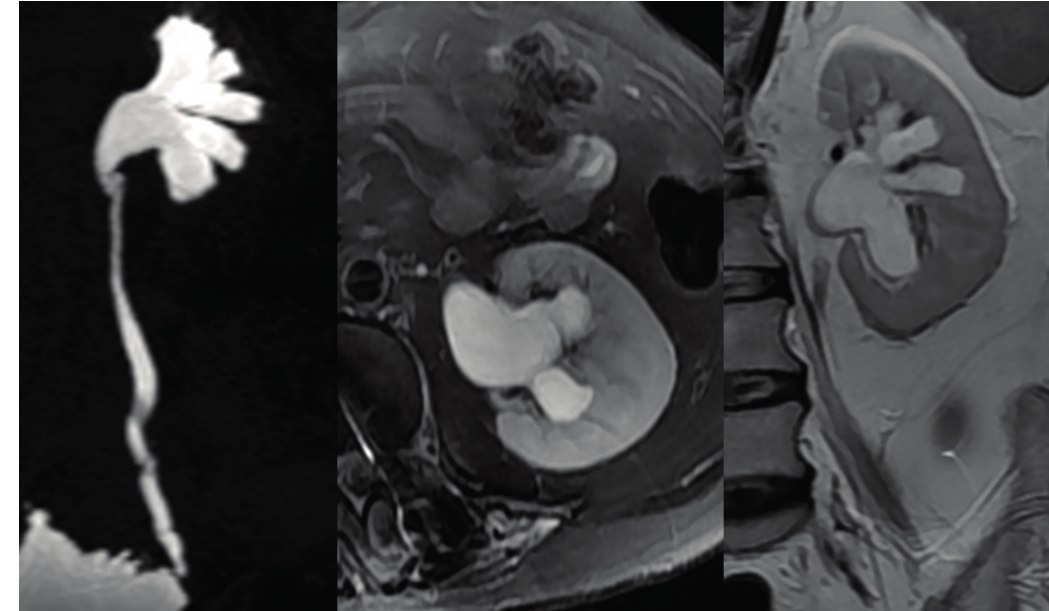
Figure 5. Grade 3 with UUTD-MRU grading